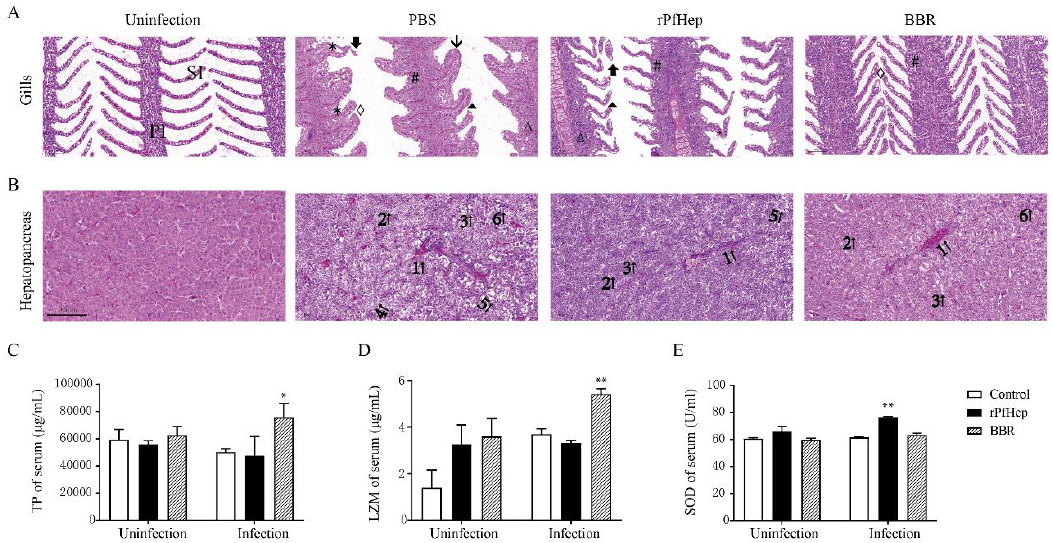
Figure 5. Effects of rPfHep and BBR on histopathological changes and serum biochemical indexes of P. fulvidraco . ( A ) The pathological sections of gills, Uninfection group, Control (infection) group, rPfHep group, BBR group, Gill filament (PI); Gill lamella (SI). In the control group, the proliferation of gill filament epithelial cells was observed, and the gill pieces were severely proliferated and fused into a plate shape. As a result, the histopathological changes of rPfHep group and BBR group were better than that of the control group. Epithelial hyperplasia (#); inflammatory cell infiltration ( Δ ); Curved gill lamella ( ); Epithelial edema ( ◊ ); Epithelial cells separate from capillaries to form cavities (*); Shedding and necrosis of gill pieces ( ); Gill lamella are severely proliferated and merge with adjacent gill pieces into a plate shape ( ), stained with HE. ( B ) The pathological sections of liver. In the control group, hepatocytes were enlarged; inflammatory cell infiltration and even focal necrosis appeared in the liver. However, it was not so serious in the rPfHep group and BBR group. Hepatic sinusoidal congestion (1 ↑ ); Hepatocyte pyknosis (2 ↑ ); Liver cells are enlarged and vacuoles appear (3 ↑ ); Hepatocyte nucleus lysis gradually disappears (4 ↑ ); Focal necrosis (5 ↑ ); Inflammatory cell infiltration (6 ↑ ), stained with HE. ( C – E ) Total protein (TP), lysozyme (LZM) and superoxide dismutase (SOD) in serum of yellow catfish. * p < 0.05; ** p < 0.01 versus control. After a short-term exposure to rPfHep and BBR for one day, the total protein (TP) and superoxide dismutase (SOD) levels in the rPfHep and BBR treatment group were